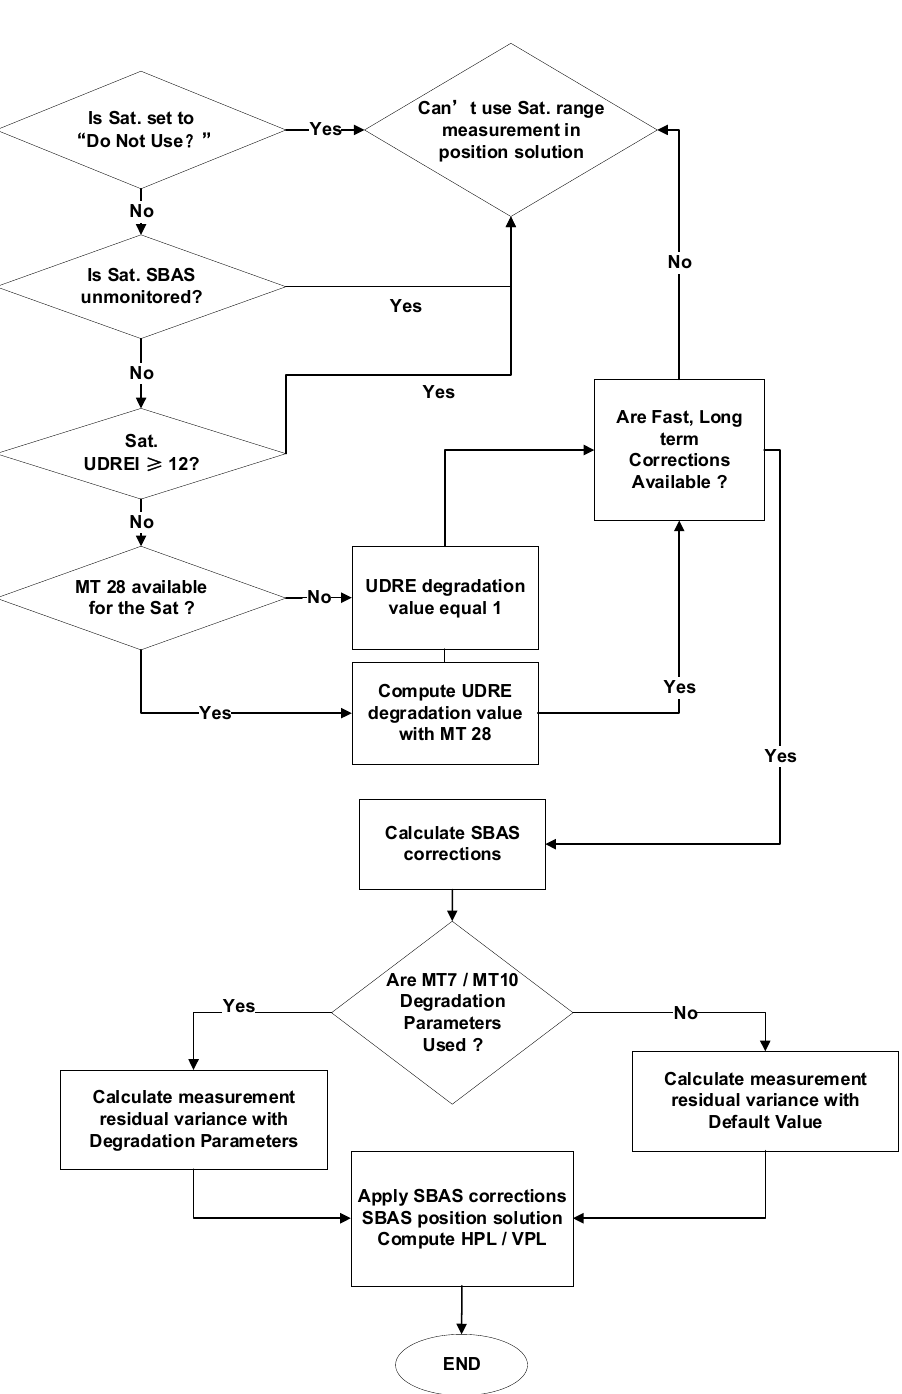
Figure 2. Algorithm flowchart of BDSBAS SF messages [19].